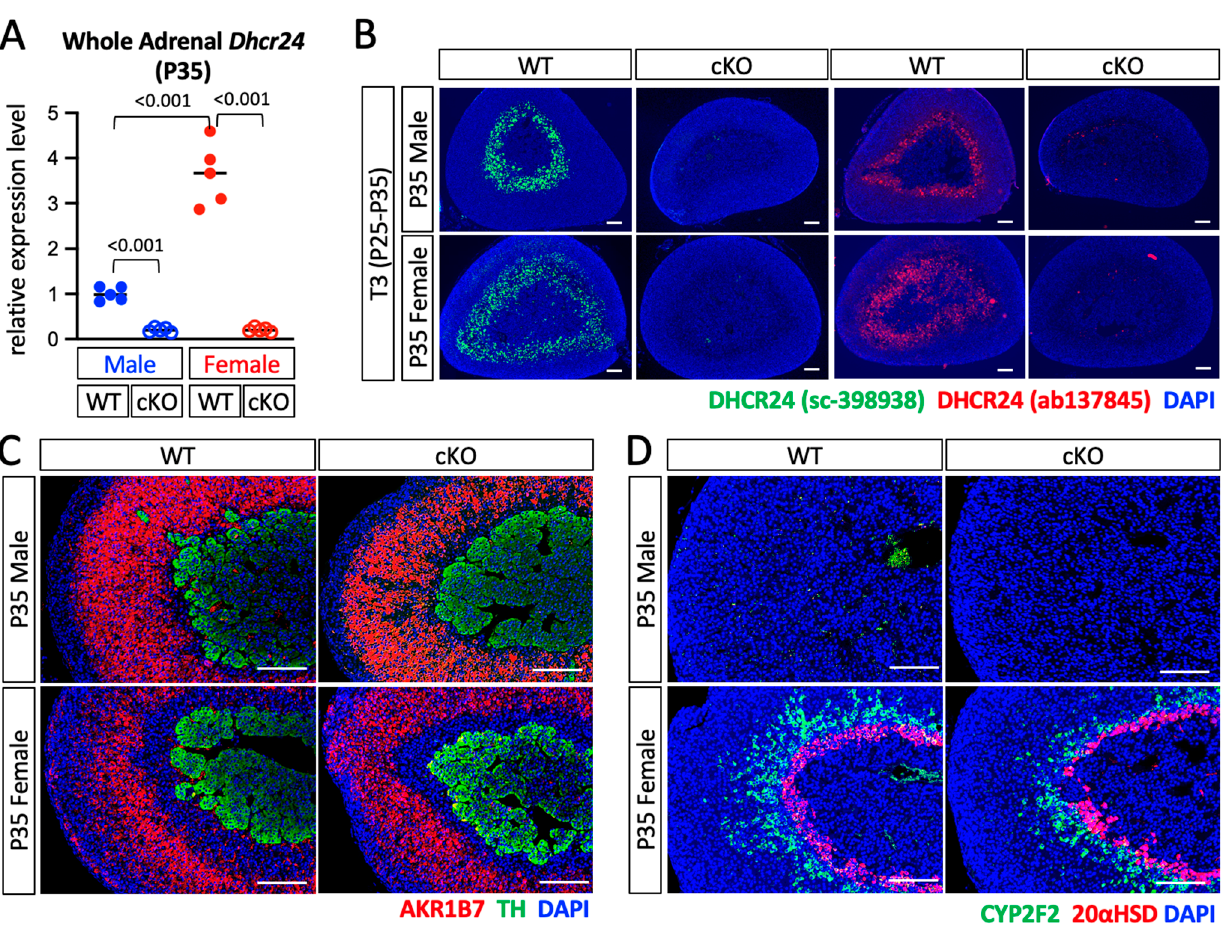
Figure 4. Phenotypic analyses of Dhcr24 cKO mice. ( A ) Quantitative polymerase chain reaction was performed to detect the relative expression levels of Dhcr24 in whole adrenal glands from cKO and WT littermates at P35. The relative expression levels of Dhcr24 in cKO mice were normalized to those of the male WT mice. Each dot (WT) and circle (cKO) represents data from one mouse. Data are shown with the mean. ( B ) Immunostaining using DHCR24 antibodies #sc-398938 and #ab137845. The mice were treated with T3 drinking water for 10 days to increase the expression level of DHCR24. The cell nuclei were counterstained with DAPI (blue). ( C , D ) Immunostaining showed areas of zona fasciculata (AKR1B7-positive), medulla (tyrosine hydroxylase (TH)-positive), and inner cortex (CYP2F2- or 20 α HSD-positive) in euthyroid P35 mice. The cell nuclei were counterstained with DAPI (blue). WT: wild-type mice, cKO: Dhcr24 conditional knockout mice. Scale bars, 130 µm.